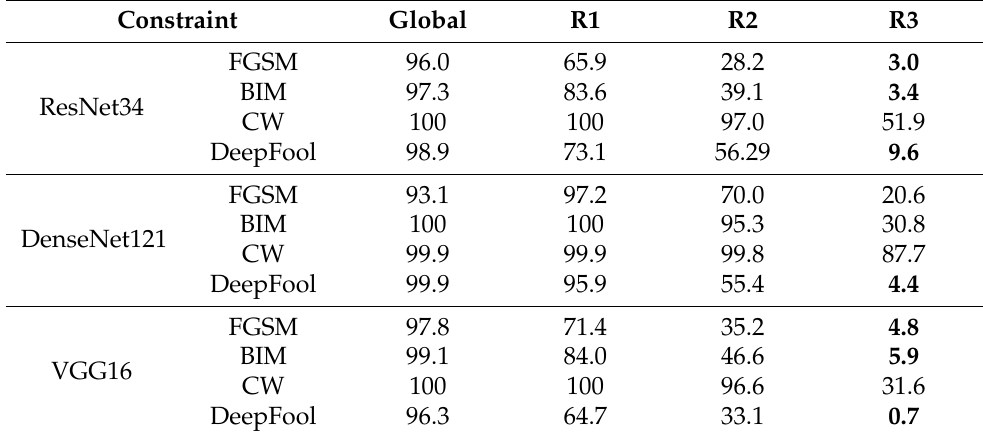
Table 2. Influence of regional constraint on attack performance